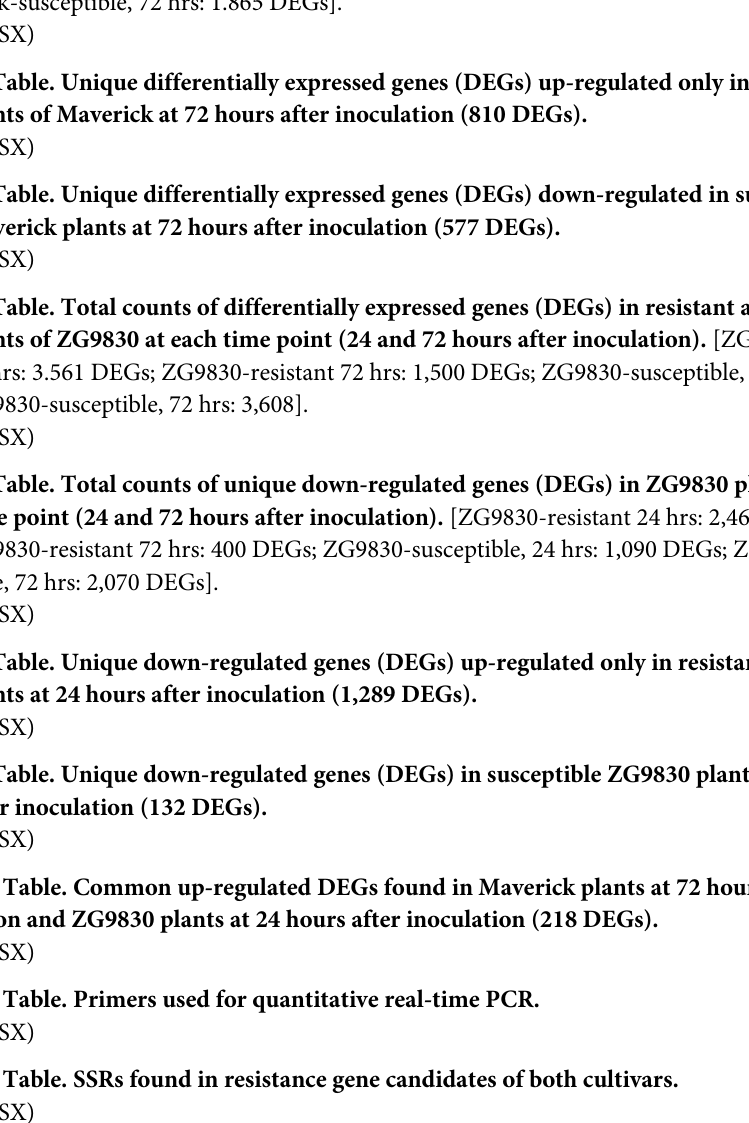
S1 Table. RNA-seq metrics. S2 Table. Total counts of differentially expressed genes (DEGs) in resistant and susceptible plants of Maverick at each time point (24 and 72 hours after inoculation). [Maverick-resis- tant 24 hrs: 1076 DEGs; Maverick-resistant 72 hrs: 2,662 DEGs; Maverick-susceptible, 24 hrs: